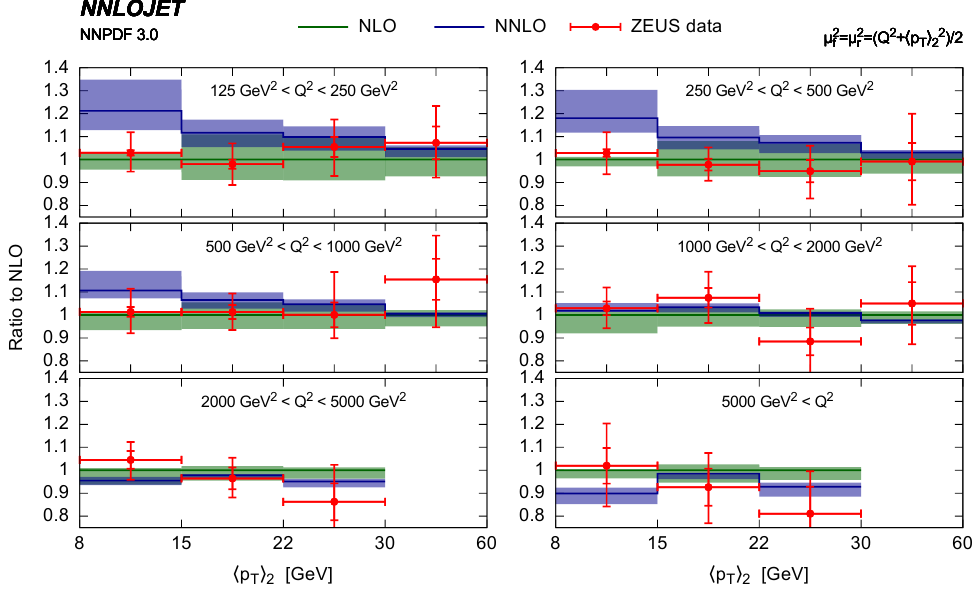
Figure 10 . Inclusive di-jet production cross section as a function of h p B to ZEUS data.